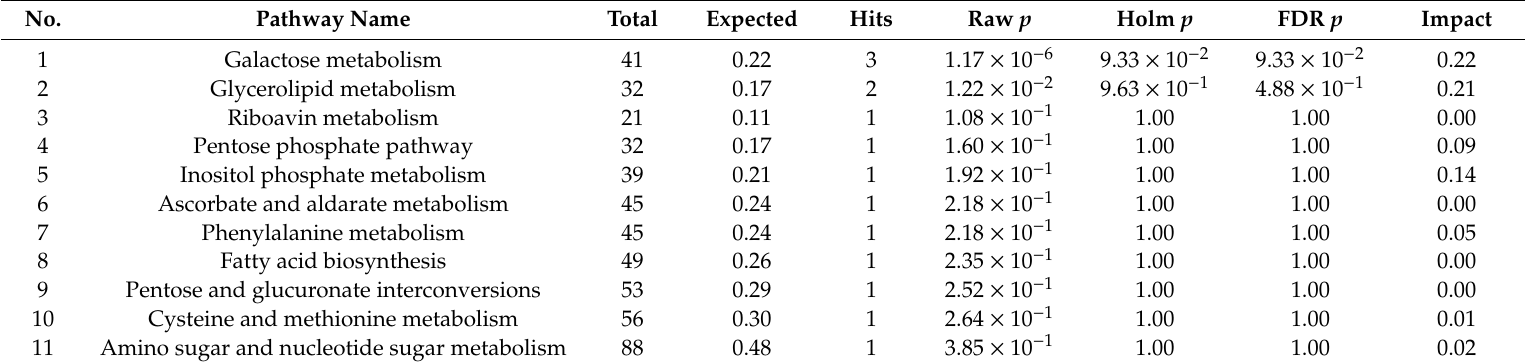
Table 2. Results from Pathway Analysis with